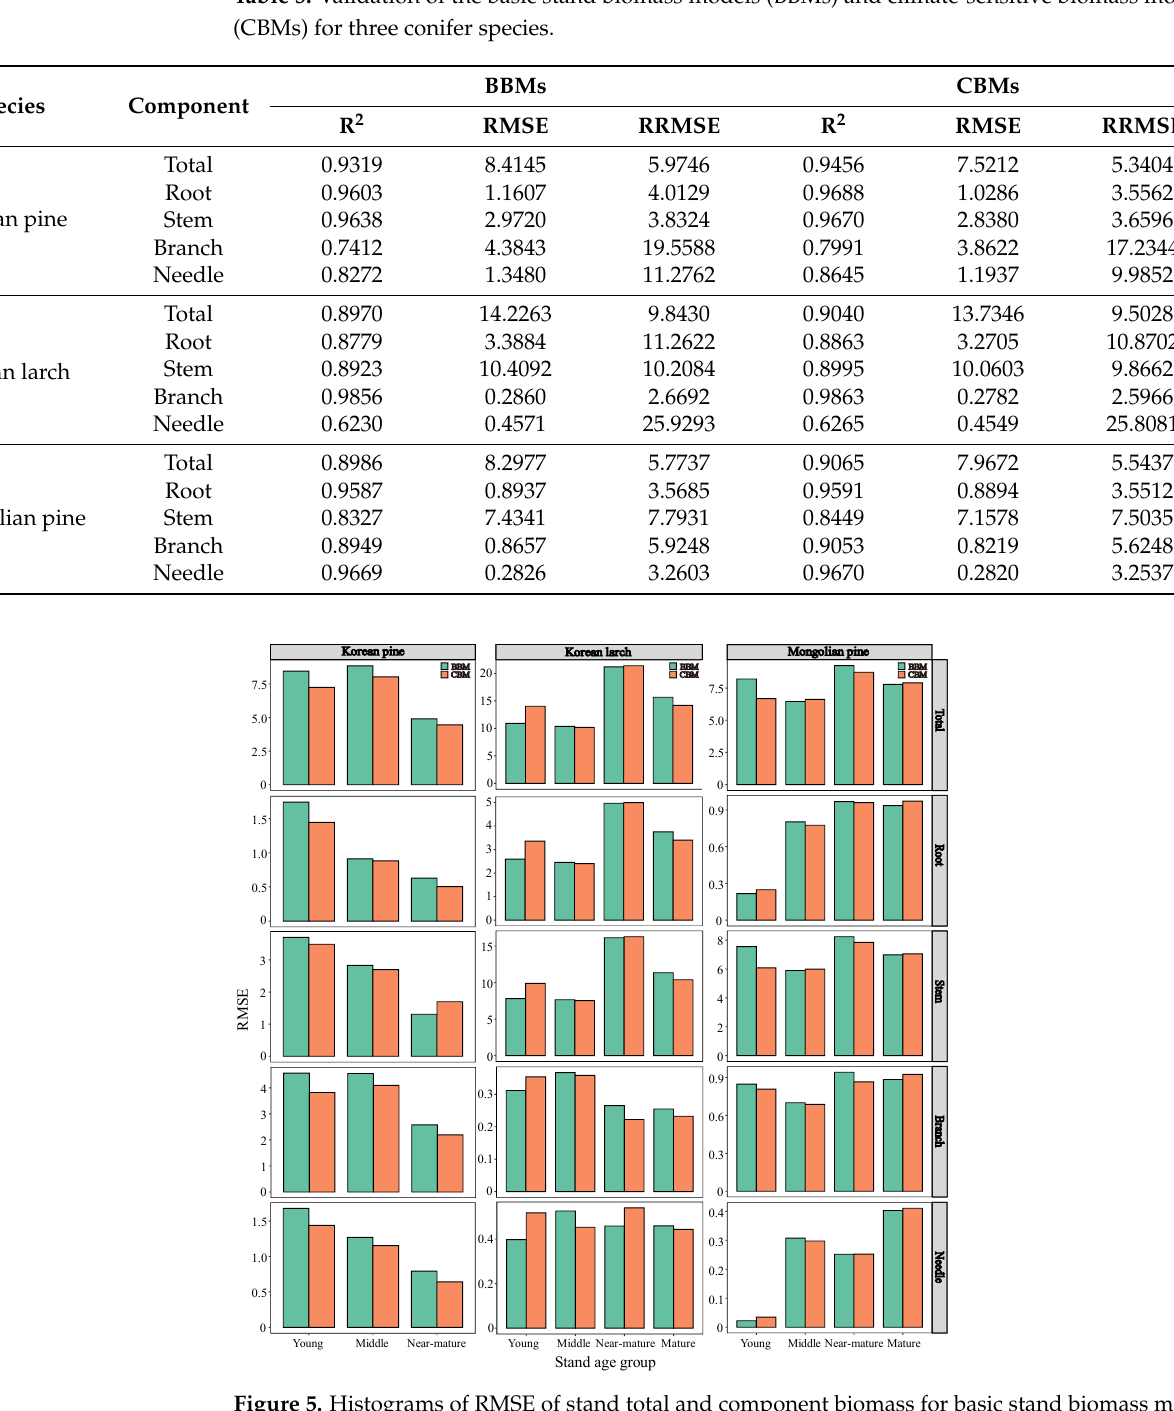
Figure 5. Histograms of RMSE of stand total and component biomass for basic stand biomass model (BBMs) and climate-sensitive stand biomass model (CBMs) against three conifer species.